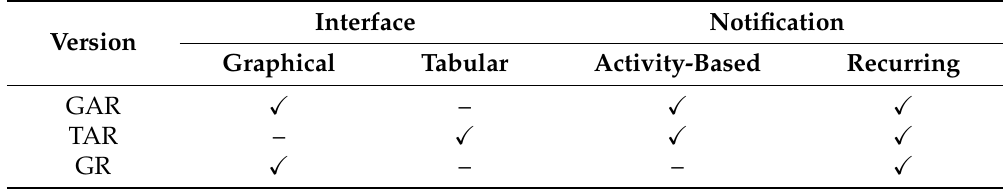
Table 3. Types of versions of PATROL